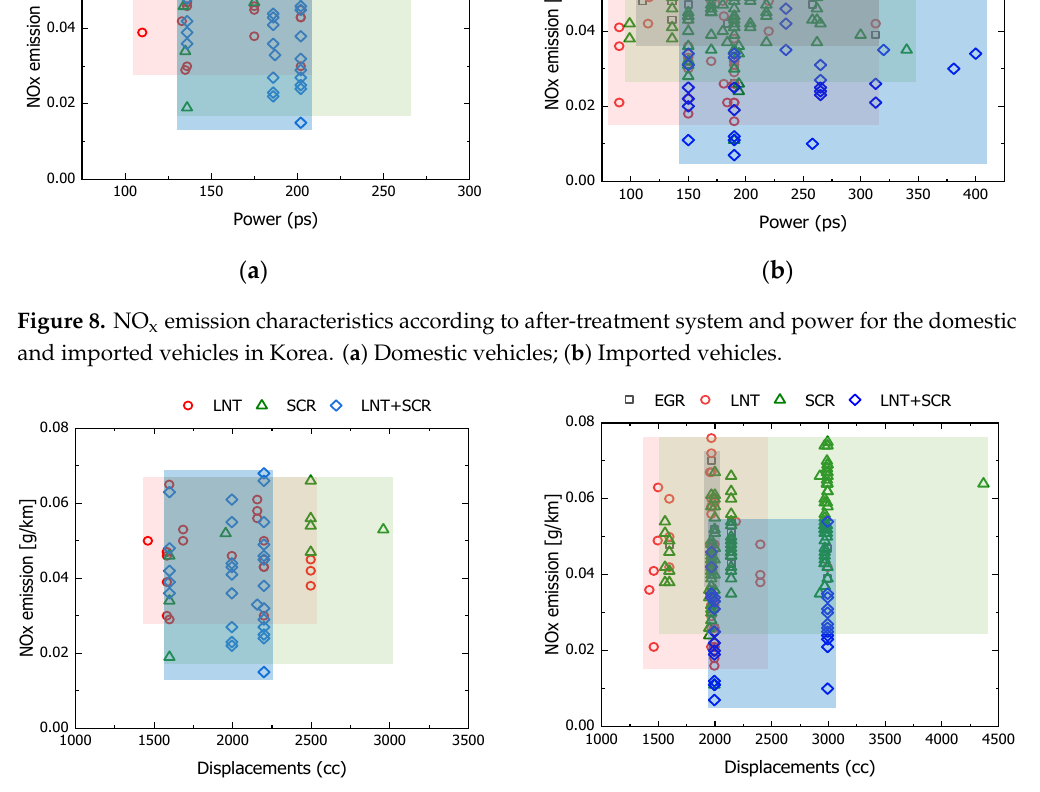
Figure 9. NO x emission characteristics according to after-treatment system and vehicle displacement for the domestic and imported vehicles in Korea. ( a ) Domestic vehicles; ( b ) Imported vehicles.